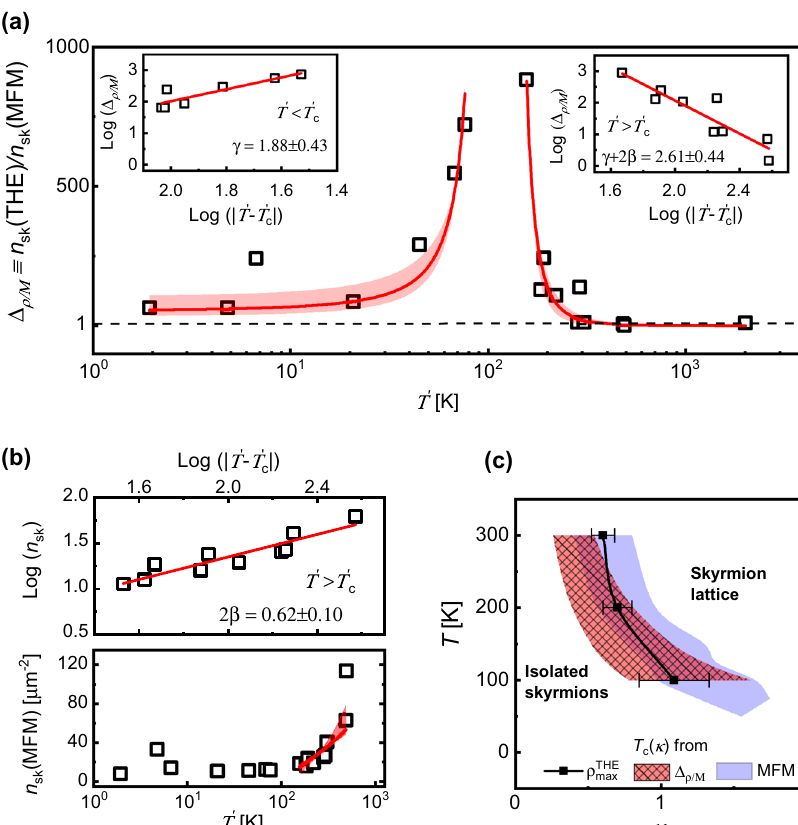
Fig. 3 Insights into the critical behavior captured by the topological Hall effect ( THE ). a Power-law behavior of Δ ρ /M ≡ n sk (THE)/ n sk (MFM) with ¼ 110 ± 15K. Insets show the estimation of critical exponents, γ for T 0 < T 0 effective temperature T 0 ¼ T (cid:2) κ , and a critical point at T 0 and γ + 2 β for T 0 > T 0 . c c c and the estimation of the critical exponent 2 β . c Identi fi cation of the critical b Evolution of n sk (MFM) with T 0 , showing a power-law behavior for T 0 > T 0 c region T c ( κ ) using three different approaches, namely, the local maximum in ρ THE with T and κ , the power-law rise in Δ ρ /M and the transition region (from isolated skyrmions to a disordered skyrmion lattice) indicated by MFM. The error bar in the estimated exponents re fl ects the error in the slope of the linear fi ts shown in the insets to ( a and b ). The same error bar is re fl ected through the shaded regions in the power-law fi ts. Error bars on ρ THE in ( c ) re fl ect the max variation in the peak position of ρ THE between Fig. 2b, c. The shaded region for T c ( κ ) from Δ ρ /M in ( c ) re fl ects a conservative estimate of ±35% variation in κ , resulting from an upper bound in the estimation of the exchange ( A ) and DMI( D ) constants as well as K 5 eff from magnetization measurements